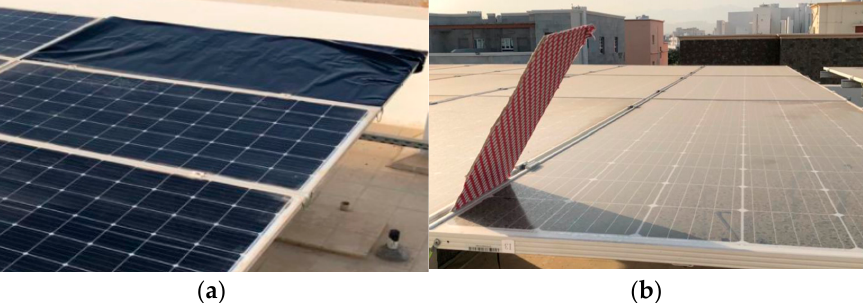
Figure 5. Example for simulation of ( a ) cloud shading by using a window tinting film. ( b ) Object shading simulation by using a carton sheet.